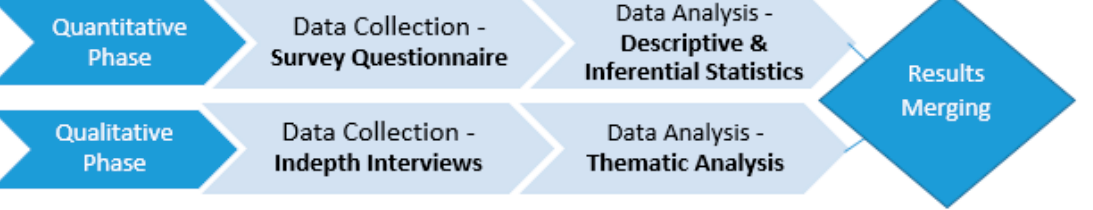
Figure 1. Concurrent Triangulation design. Source: Adapted from Creswell et al. [57].